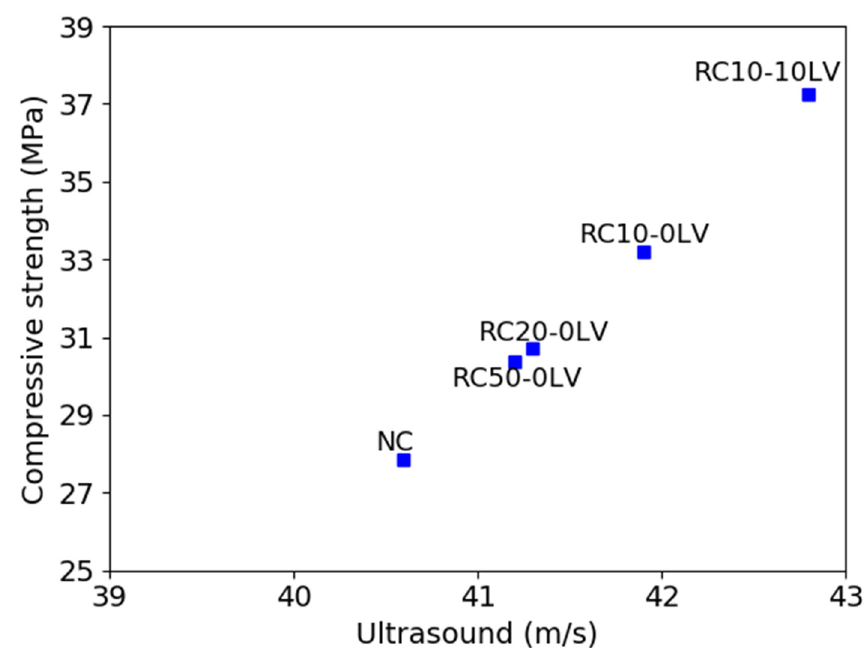
Figure 7. Ultrasound vs. Compressive strength.